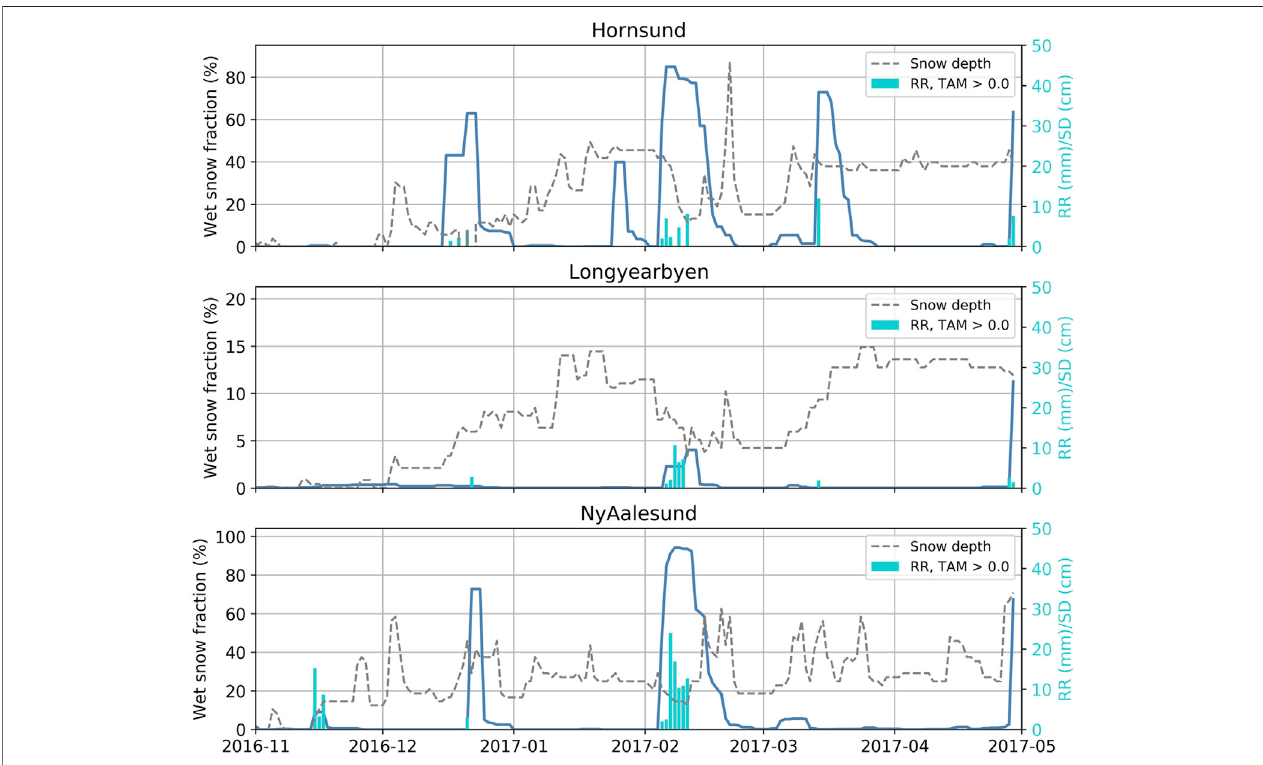
FIGURE8| ROSeventsdetectedatNyHornsund,Longyearbyen,andNyÅlesundforthe2016/2017wintercomparingmeteorologicallydetectedROSeventsand SARwetsnowfraction.Precipitationisshownbythelightbluebarsfordaysful fi llingROScriteria[meantemperature( “ TAM ” ) > 0 ° C,totaldailyprecipitation( “ RR ” ) > 1 mm and snow depth SD > 2 cm]. Wet snow fraction for land pixels < 100 m. a.s.l in a 10 km × 10 km box around the three sites is shown as a time series by the dark blue